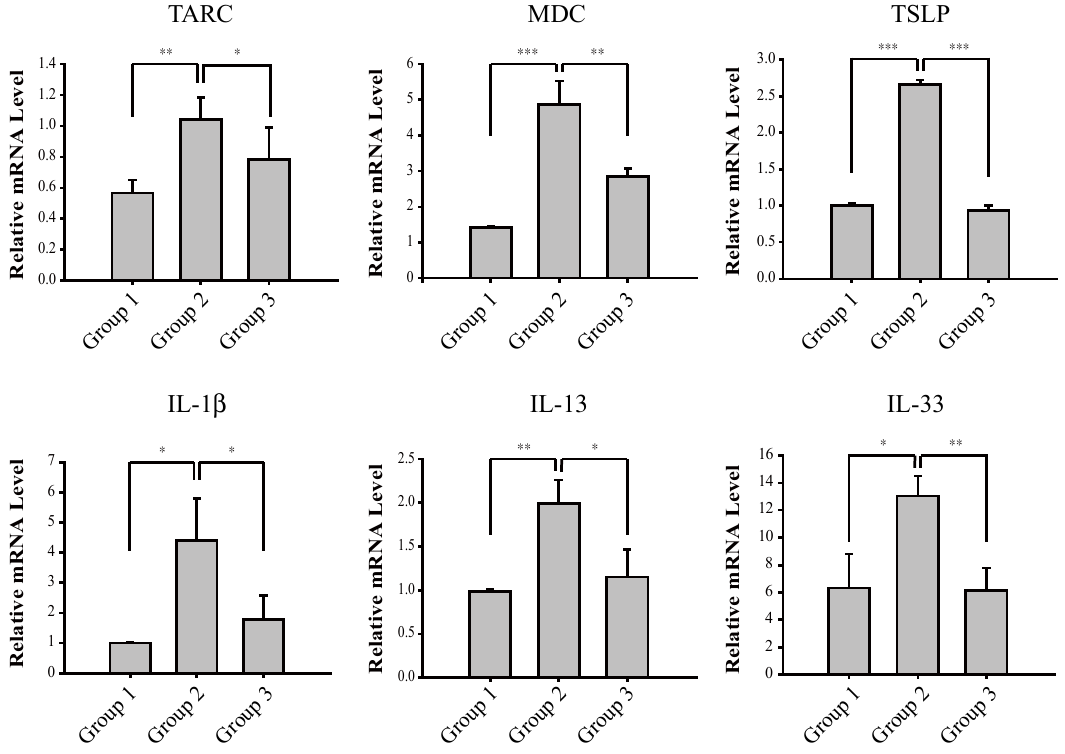
Figure 3. Cardamonin mediates transcriptional suppression of oxazolone-induced production of Th2 cytokines in vivo. The mRNA levels of Th2 cytokines in mouse skin were measured by real-time RT-PCR analysis. Asterisks indicate a statistical significance of * p < 0.05, ** p < 0.01 and *** p < 0.001.